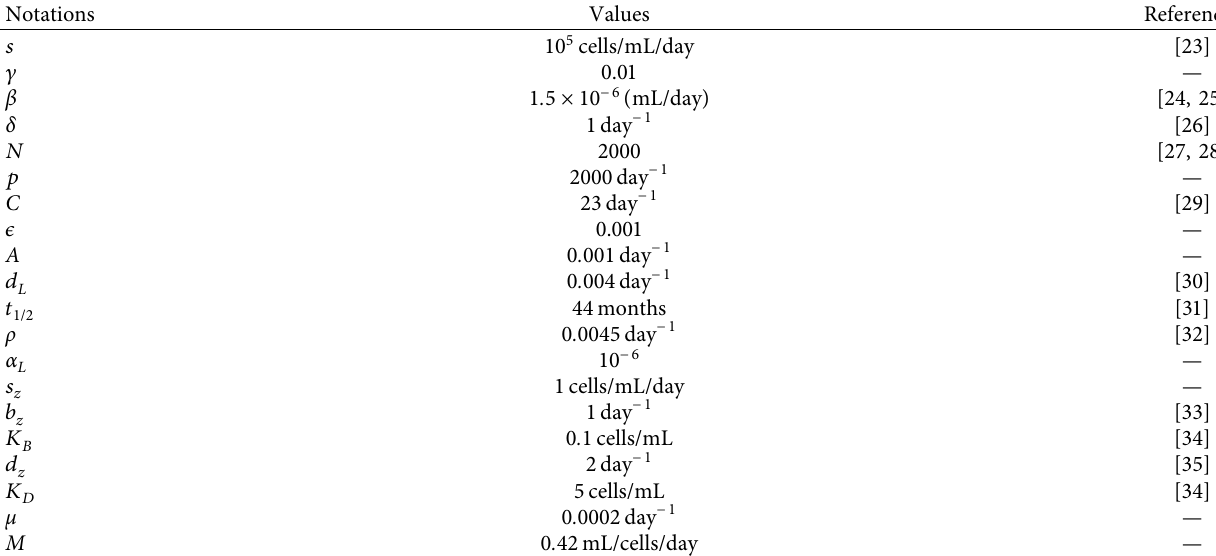
Table 1: Parameter values and their sources.